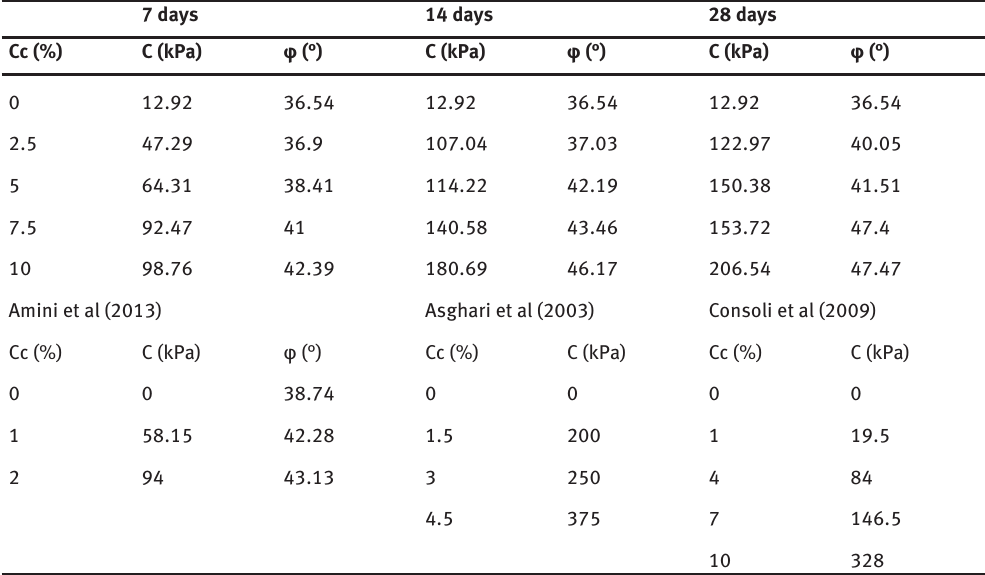
Table 4: Summary of our results with those found in the